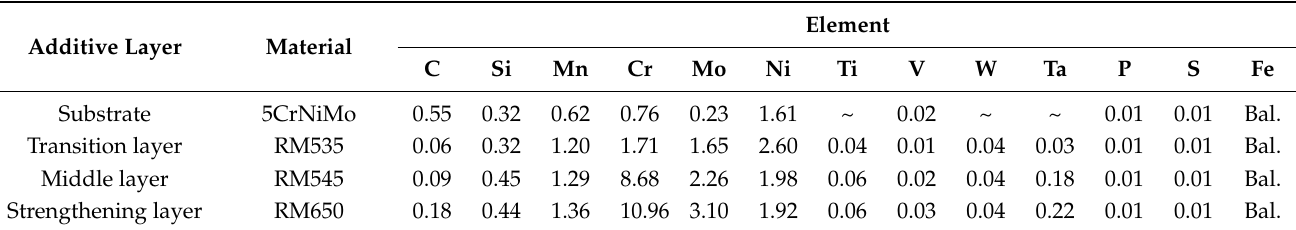
Table 3. Chemical composition (wt.%) of 5CrNiMo steel and additive